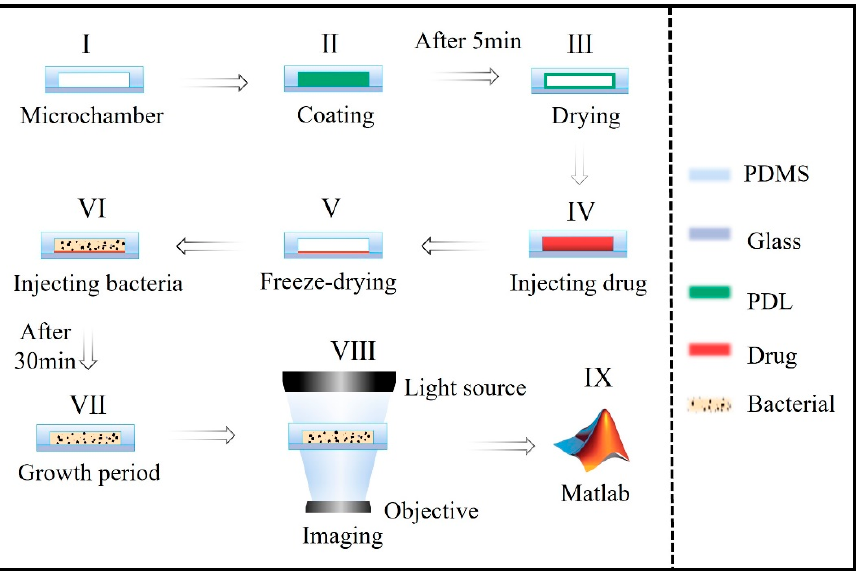
Figure 3. The operational process of the single-cell level rapid AST system. (I) Side view of the section of the micro chamber. (II) Injection of PDL to modify the microchamber. (III) Microchamber after coating with PDL. (IV) Injection of drug in the microchamber. (V) Freeze-drying of drug using the lyophilizer. (VI) Injection of bacterial suspension into the microchamber. (VII) The freeze-dried drug dissolves in the bacterial suspension and time is allowed for cell proliferation. (VIII) Tracking bacteria proliferation by microscopy with photographs taken every 5 min as one photo. (IX) Enumeration of bacteria at each time point and Matlab automatic compilation of data and generation of growth